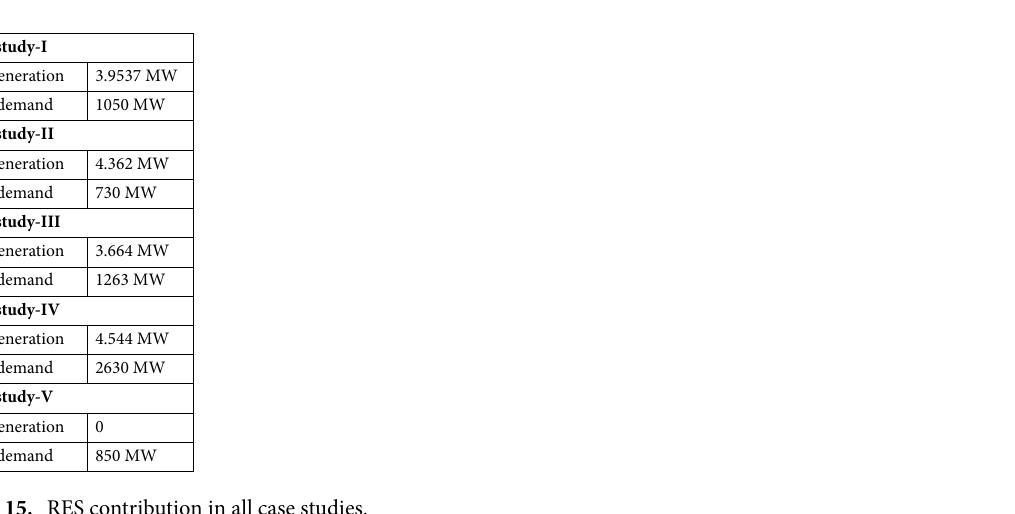
Table 15. RES contribution in all case